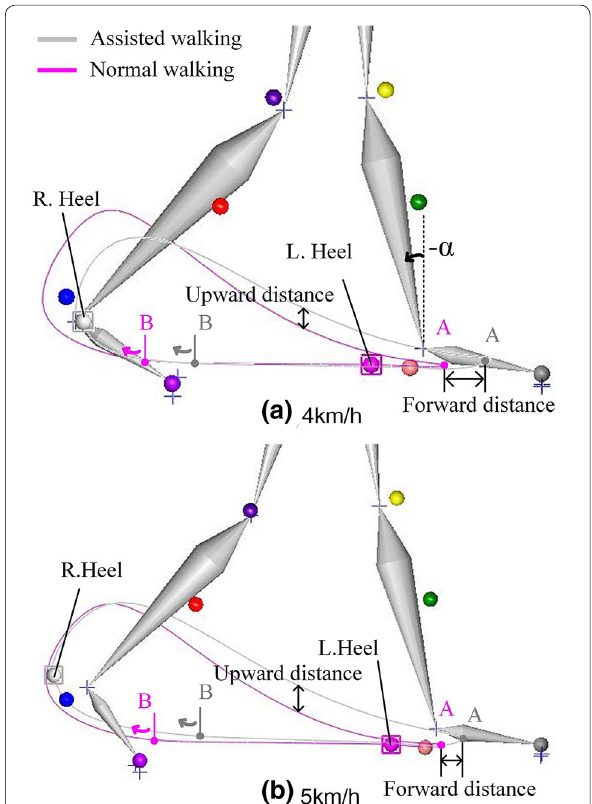
Figure 9 Tracks of the markers on both feet in one gait cycle (the right foot is assisted by the PAFE, whereas the left foot is in a casual